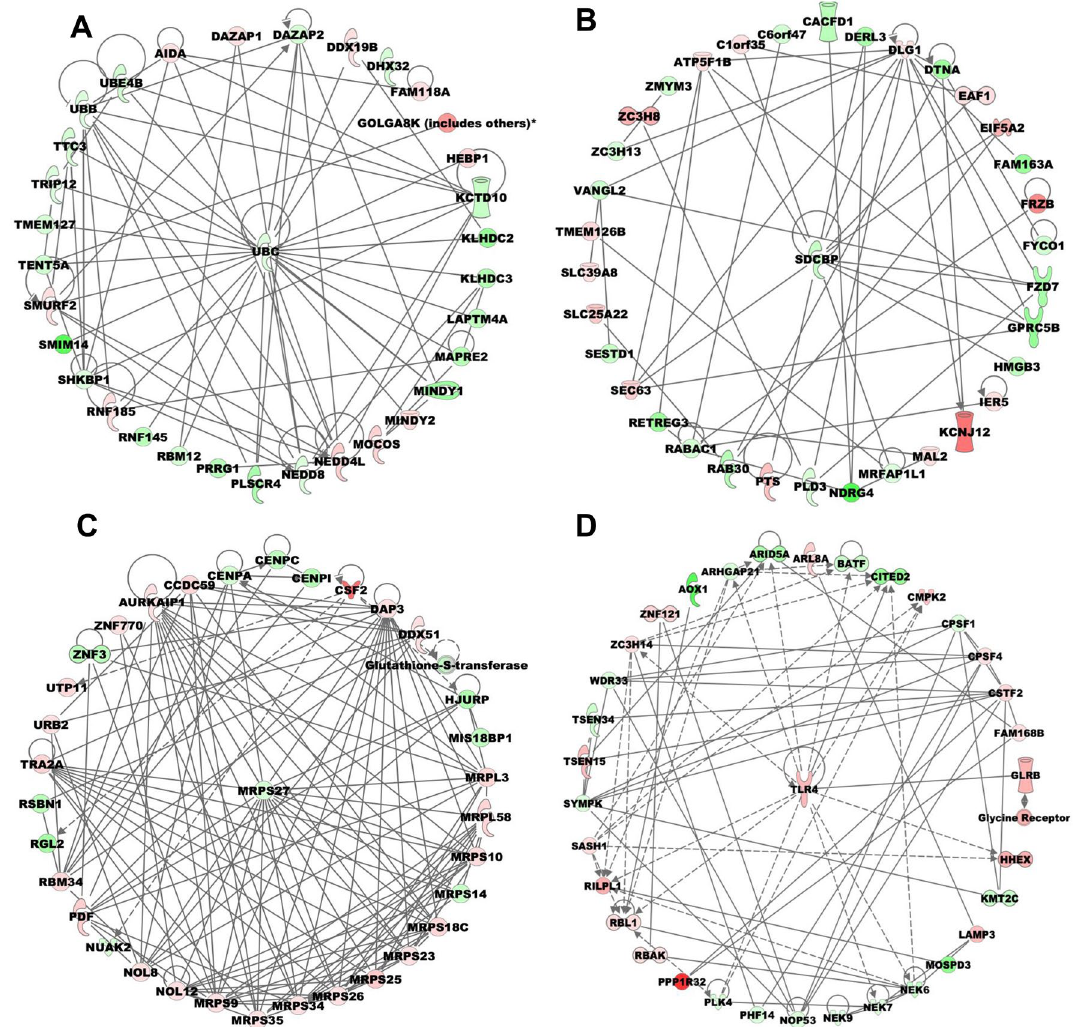
Figure 5. Impact of SFPQ on gene networks. The radial representations indicate the most enriched networks that are predicted to explain the differences in gene expression between SFPQ over-expressed and control CFBE41o − cells. ( A ) Network 1: post-translational modification, protein degradation, protein synthesis; ( B ) Network 2: cell cycle, cell morphology, cellular assembly and organization; ( C ) Network 3: cellular assembly and organization, DNA replication, recombination, and repair, protein synthesis; ( D ) Network 4: cellular function and maintenance, molecular transport, RNA trafficking. Green color denotes low expression or down regulation, red color denotes upregulation whereas grey color denotes those present within our data set but not changed significantly. Solid arrows represent the genes that interact directly, dotted arrows represent indirect interactions between